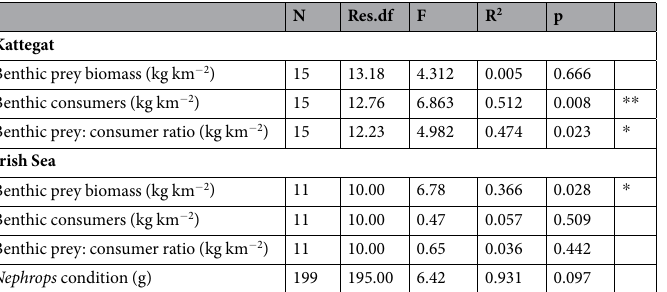
Table 1. GAM and GAMM statistical outputs for response variables tested individually against the independent variable trawling frequency y − 1 (results also displayed in Fig. 2A–F). Res.df are the residual degrees of